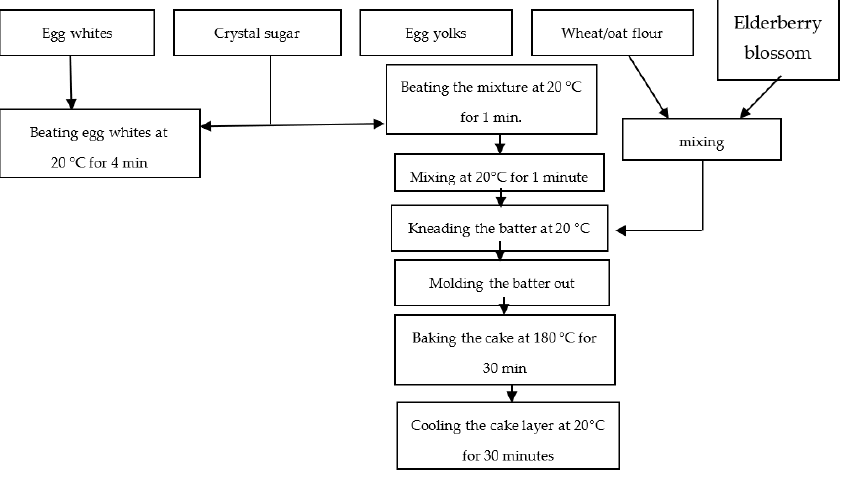
Figure 8. Technological scheme for the preparation of sponge cakes with the addition of Sambucus nigra L. flour (5, 10, and 15%).